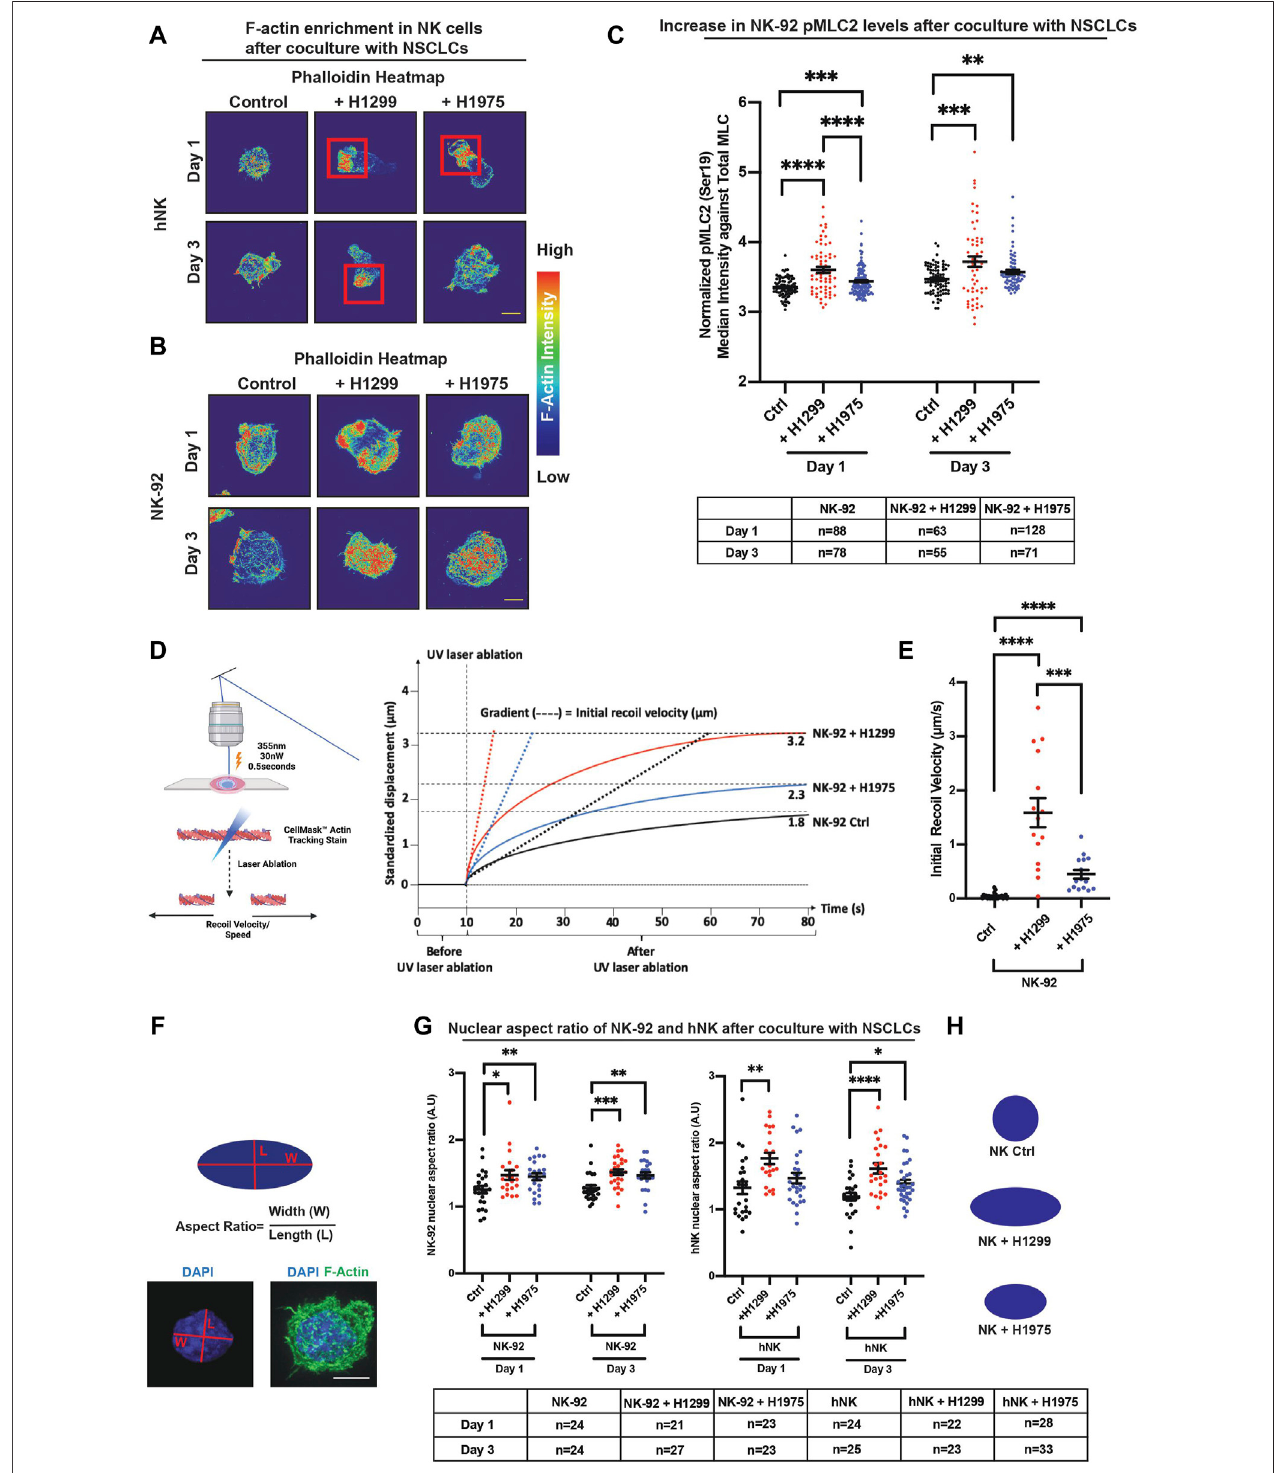
FIGURE 3 | NSCLCs activated NK cellular contractility and induced nuclear fl attening. (A) SIM super-resolution images show localised enhancement of F-actin concentration in hNK cells that were cocultured with NSCLCs. Red squares highlight areas of F-actin enrichment in hNK cells that were cocultured with NSCLCs. All sampleswerestainedwithamastermixofphalloidin,speci fi cforF-actin,andlaserpowerandexposuresettingswerekeptconstantacrosssamplesimaged.Scalebar= 5 μ m. (B) NK-92cellsshowedanincreaseinF-actinintensityaftercoculturewithNSCLC,correspondingtoanincreaseinF-actinheatmapontheright.Allsamples